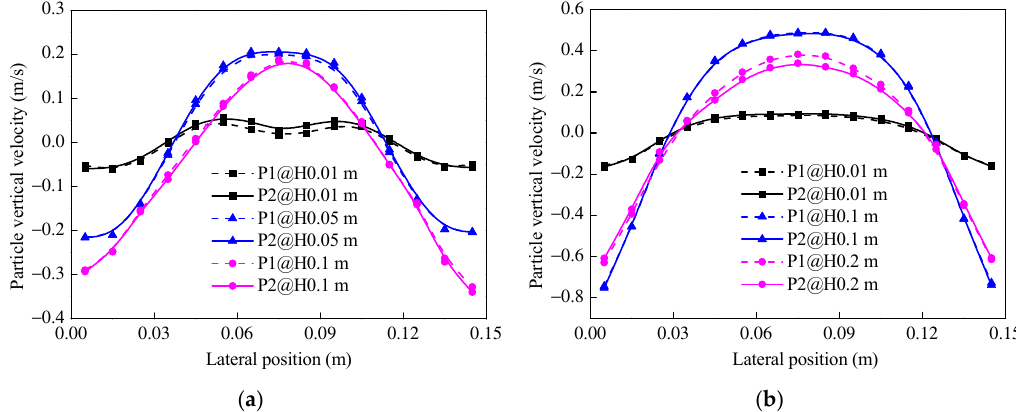
Figure 10. Time-averaged profiles of solid vertical velocity under different superficial gas velocities: ( a ) 1.5 m/s; ( b ) 3.0 m/s.